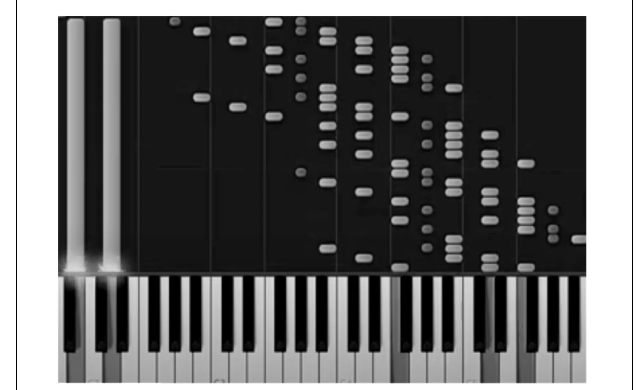
FIGURE 1 | Waterfall flow music score. Free source image, available from